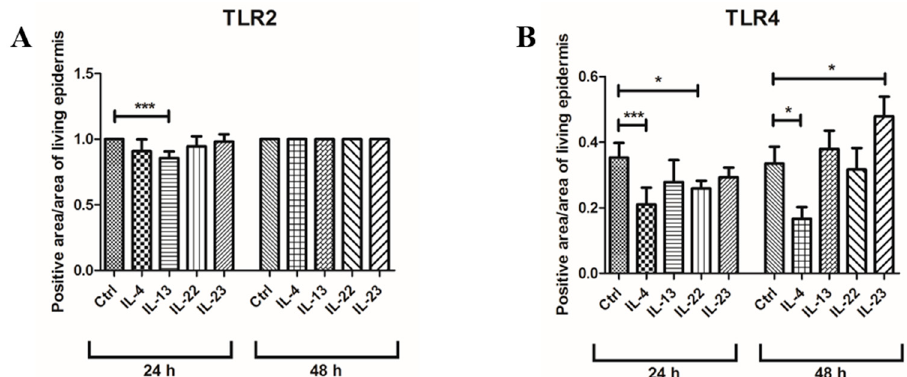
IL-22: interleukin 22; IL-23: interleukin 23; DAPI: 4 ′ , 6-diamidino-2-phenylindoledihydrochloride. White dotted line indicates the basal membrane. White arrows indicate positive immunostaining— scale bars: 50 μ m.